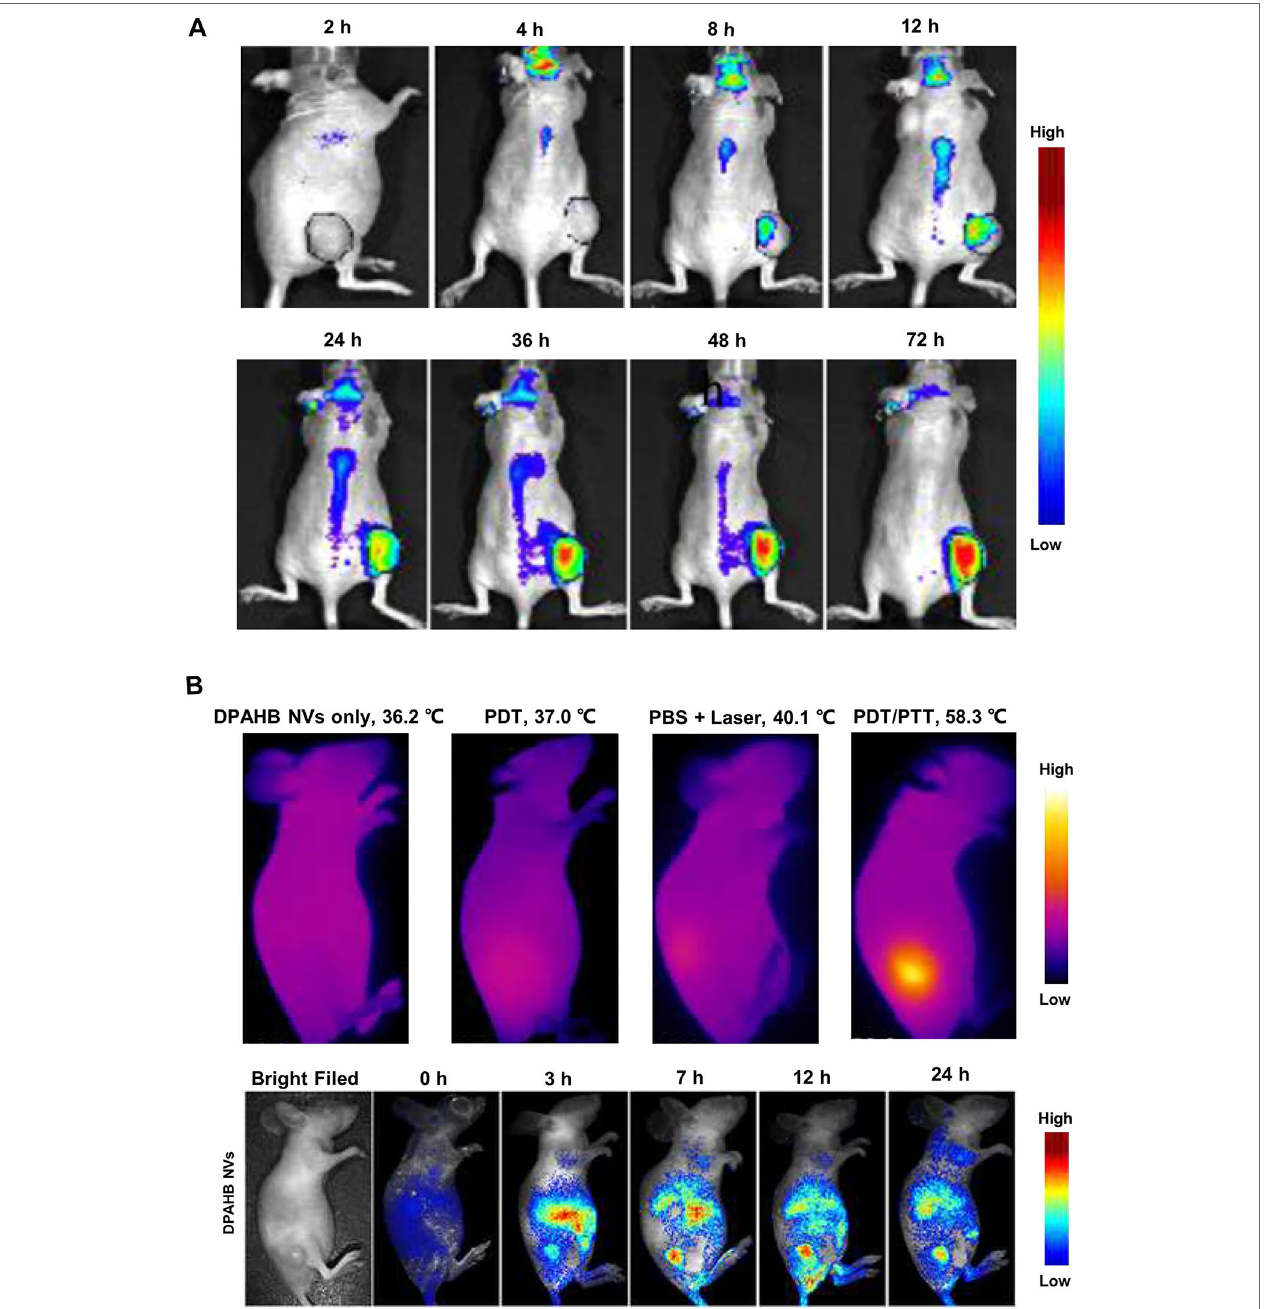
FIGURe 2 | Macroscopic imaging of natural products in living animal experiments. (A) Delivery process of gambogic acid in nude mice implanted with HT-29 cells. Adapted with permission from Ref. Huang et al., 2015. (B) Fluorescence images and infrared camera imaging results show that DPAHB nanovesicles can be used for both NIR fluorescence imaging and photothermal. Adapted with permission from Ref. Zheng et al., 2018.